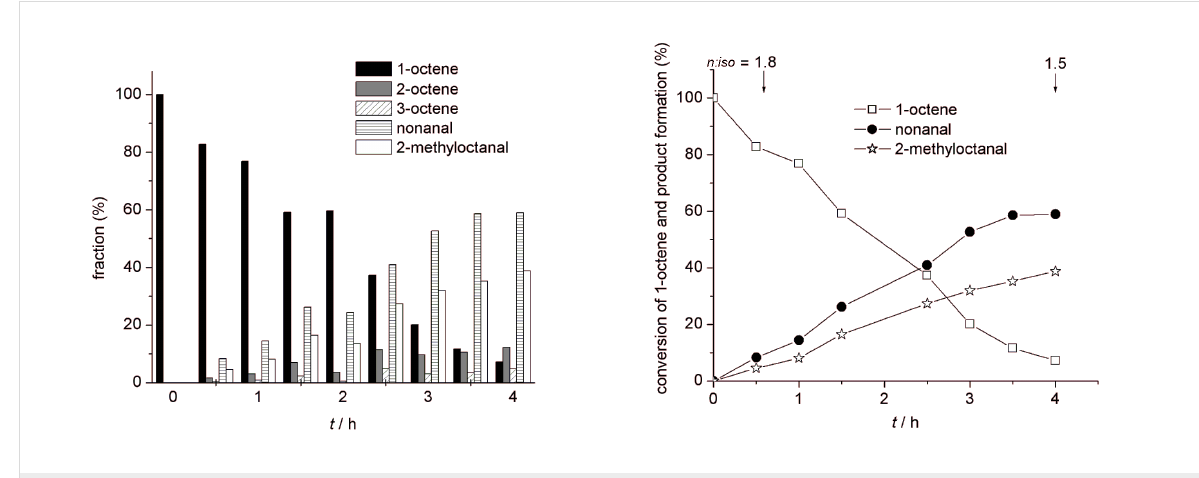
Figure 1: Conversion (%) of 1-octene, product formation, product distribution, as well as time dependant n : iso ratio in the hydroformylation of 1-octene in water in the presence of poly( M1 - b - M2 )- Rh .